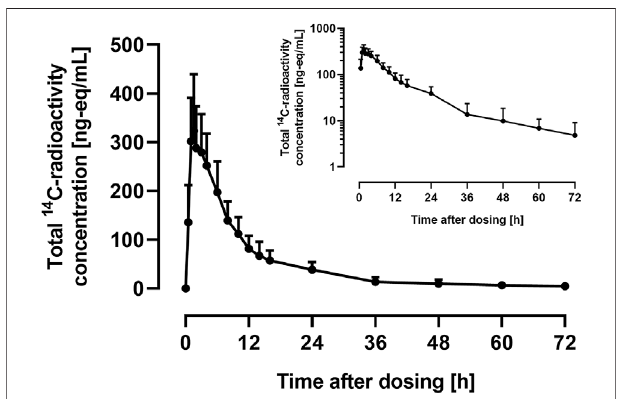
FIGURE 2 | Arithmetic mean (+SD) concentration vs. time pro fi le of total 14 C-radioactivityinplasmaonlinearandsemilog(inset)scalefollowingasingle oral administration of 9.2 μ g 14 C-ACT-1004-1239 on top of 100 mg non- radioactive ACT-1004-1239 ( N =